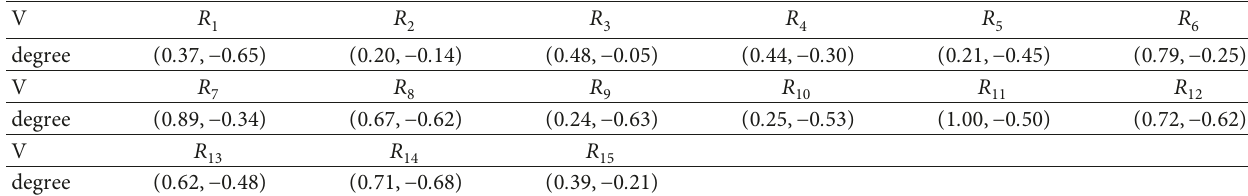
Table 4: Bipolar-valued fuzzy membership degrees of